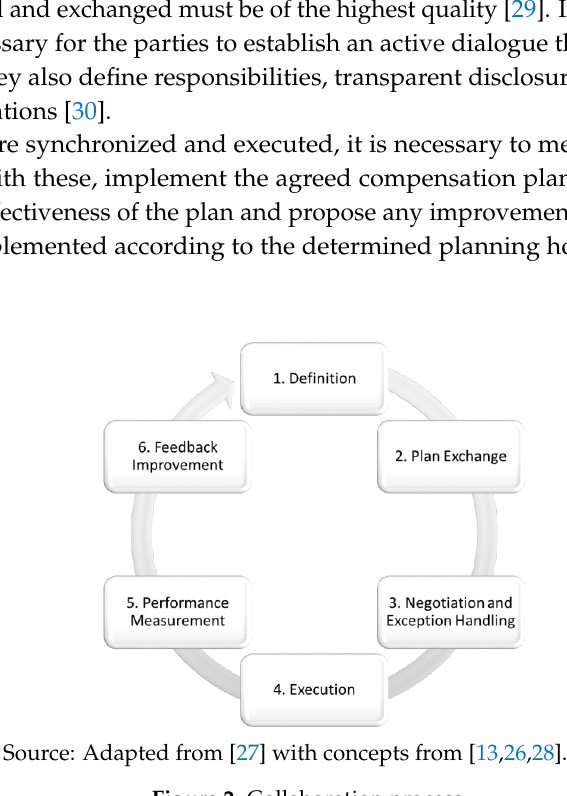
Figure 2. Collaboration process.